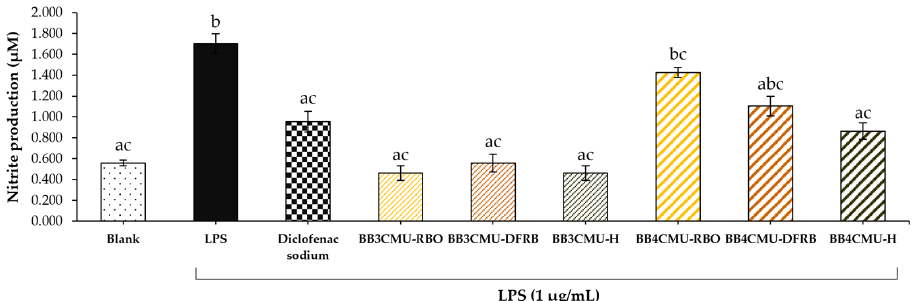
Figure 2. Effects of Oryza sativa L. cv. BB3CMU and BB4CMU extracts (RBO, 0.10 mg/mL; DFRB, 0.0001 mg/mL; H, 0.10 mg/mL) on nitrite content in RAW 264.7 macrophages induced with 1 µg/mL lipopolysaccharide (LPS) for 24 h. Diclofenac sodium (0.10 mg/mL) was used as standard control. Cells cultured in the medium without treatment refer to the blank. Different letters within each treatment indicate significant differences ( p < 0.05).